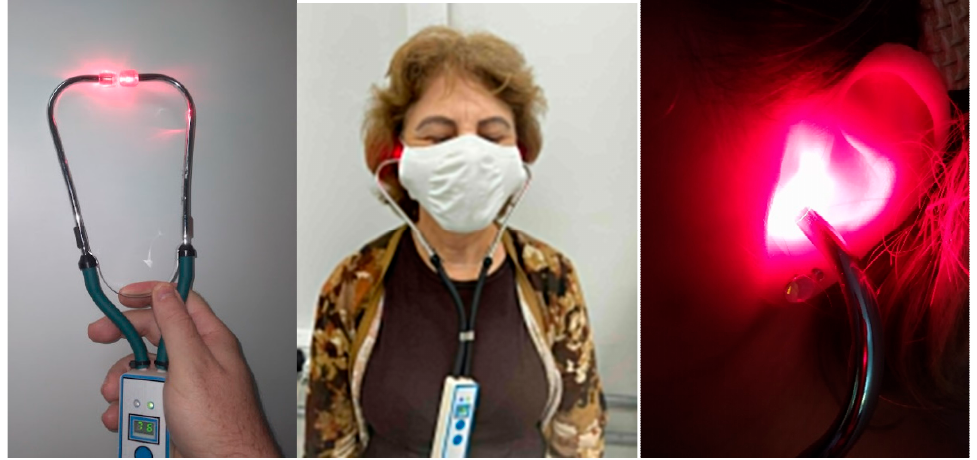
Figure 3. LLLT prototype device applying red laser with a wavelength of 660 nm developed at the Technological Support Laboratory of IFSC-USP for laser auriculotherapy.